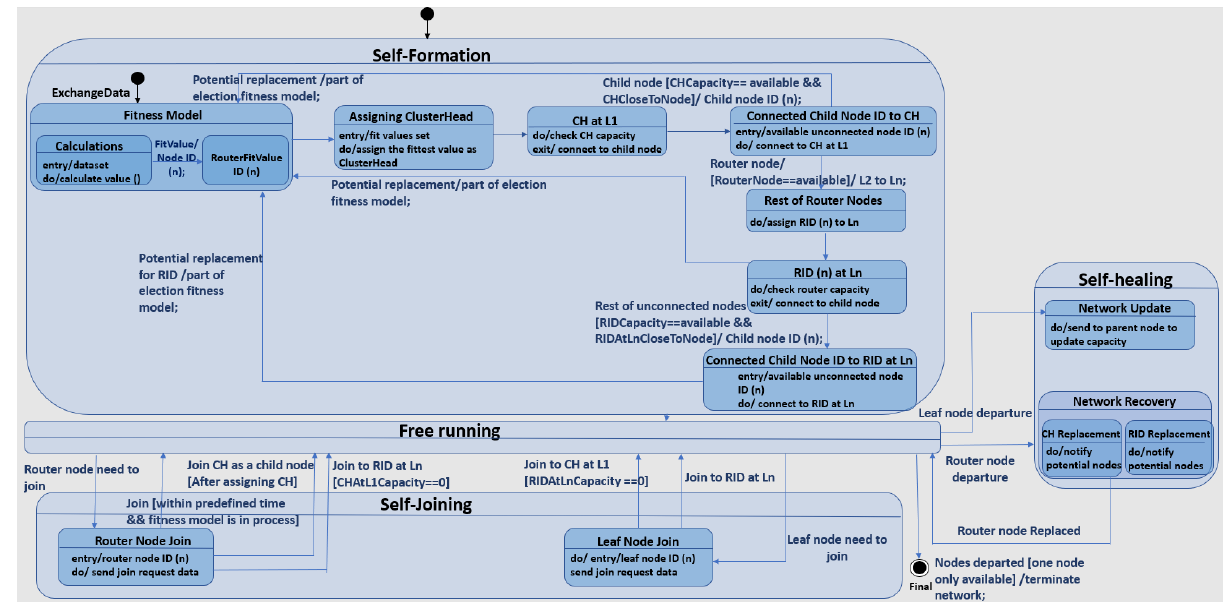
Figure 3. Self-X grouping phases in the detailed state machine.